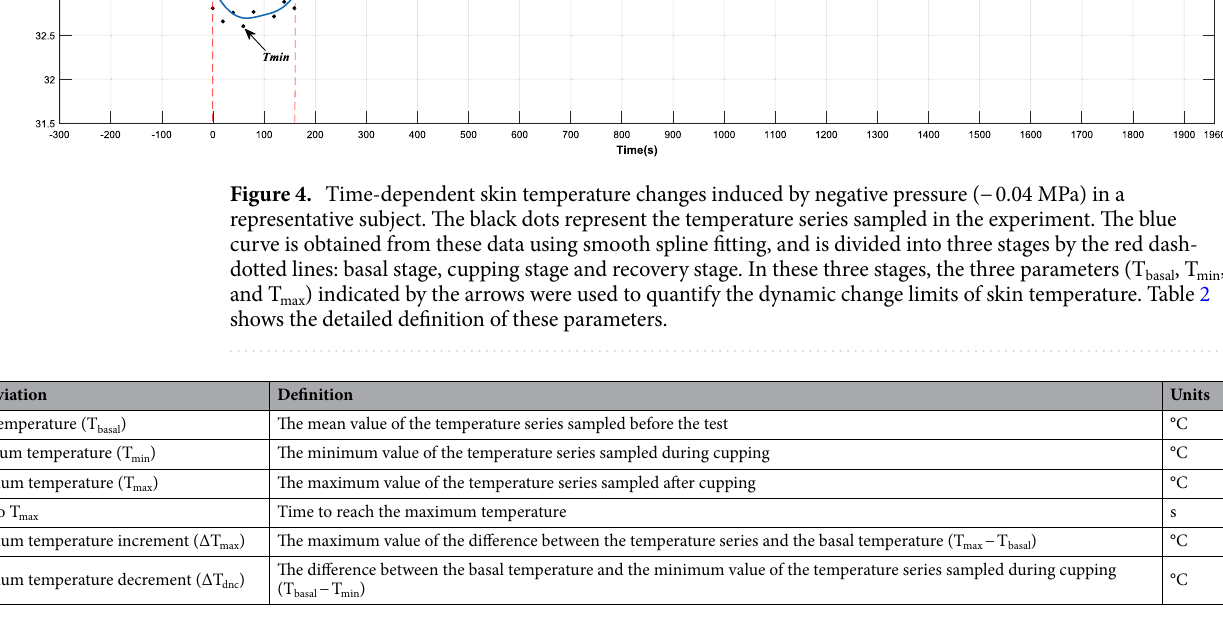
Table 2. Representative parameters describing the skin temperature time